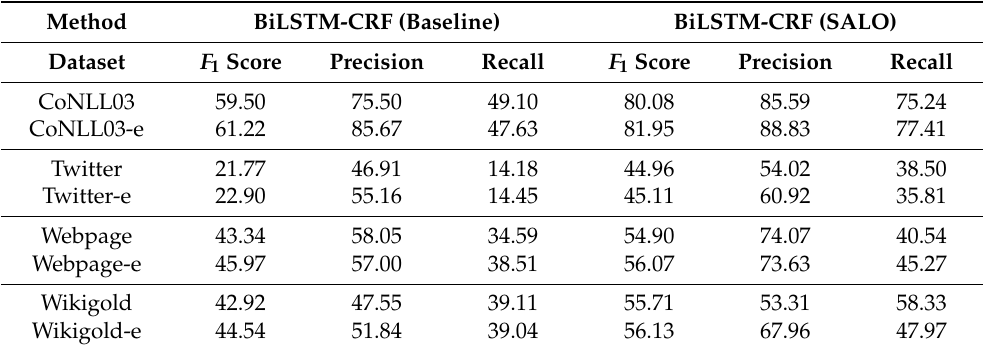
Table 5. Comparison of BiLSTM-CRF baseline and SOLO on CoNLL03, Tweet, Webpage and Wikigold datasets, in terms of F 1 score, Precision and Recall (in %). Results using original noisy labels and extended labels (denoted with -e) are both presented.